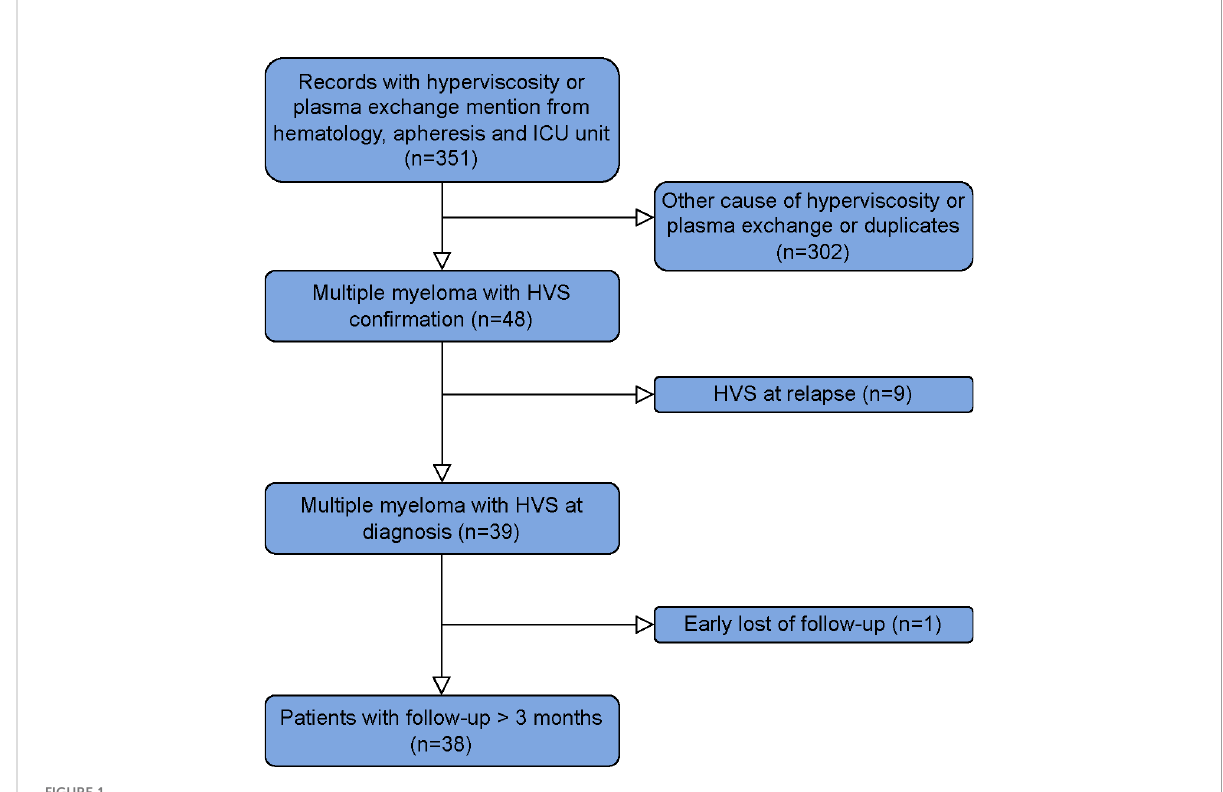
FIGURE 1 Flowchart of the